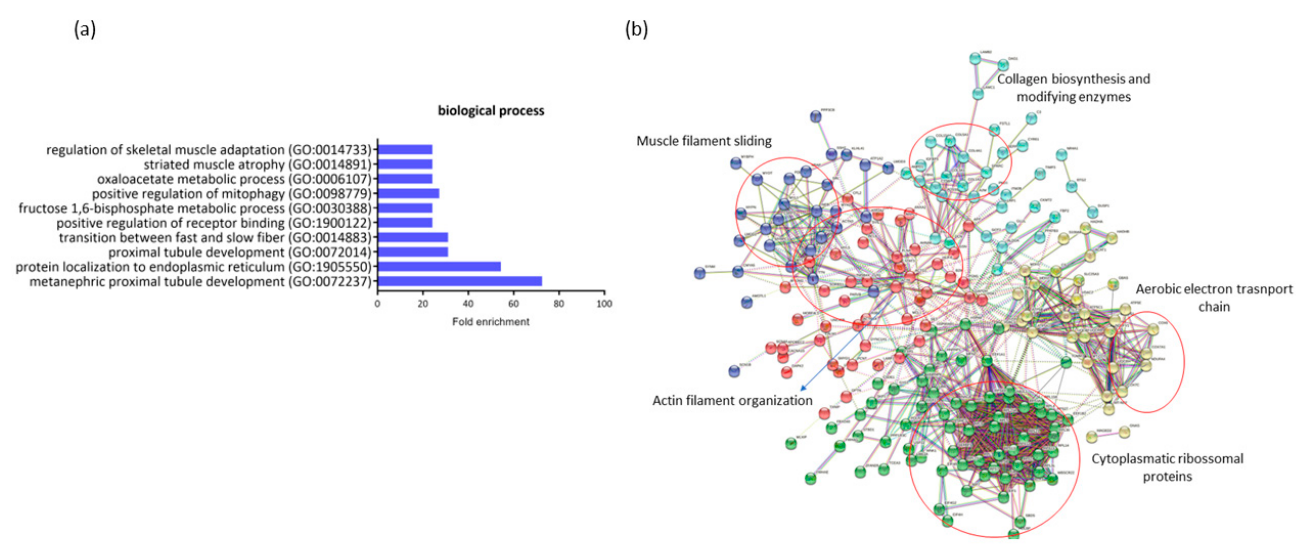
Figure 4. Profiling of differentially expressed genes (DEGs) of non-diabetic incontinent women (ND-I) in comparison with gestational diabetic and incontinent women (GDM-I). ( a ) Biological processes were identified for up- and downregulated genes. Enrichment was defined as the 10 most significant terms according to the highest scores and p -values (<0.05). ( b ) Protein–protein interaction network representing DEGs. The interaction map was generated using STRING with clusters, a high confidence of 0.7, and all criteria for linkage (co-occurrence, co-expression, experiments, neighborhood, databases, text-mining, and homology). The genes used in this network are listed in Supplemental Table S1.